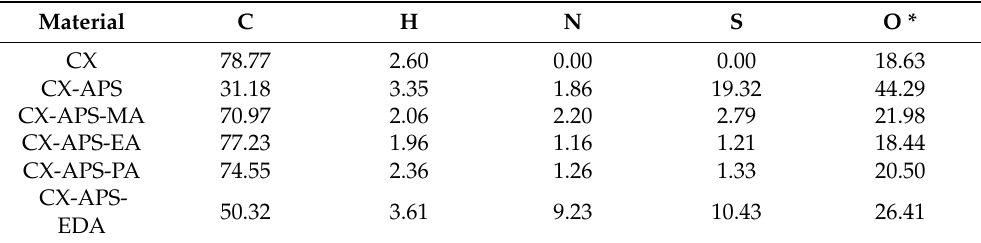
Table 1. Elemental analysis of the samples studied (wt.